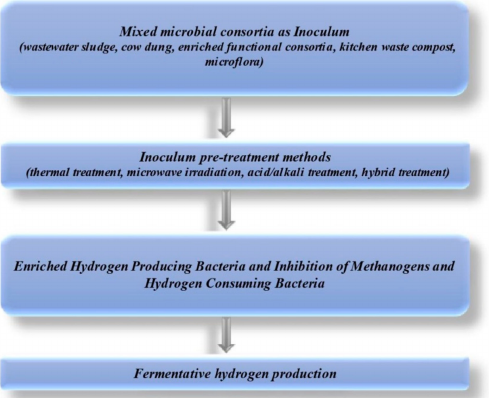
Figure 3. Inoculum pretreatment approaches for biohydrogen production by mixed microbial